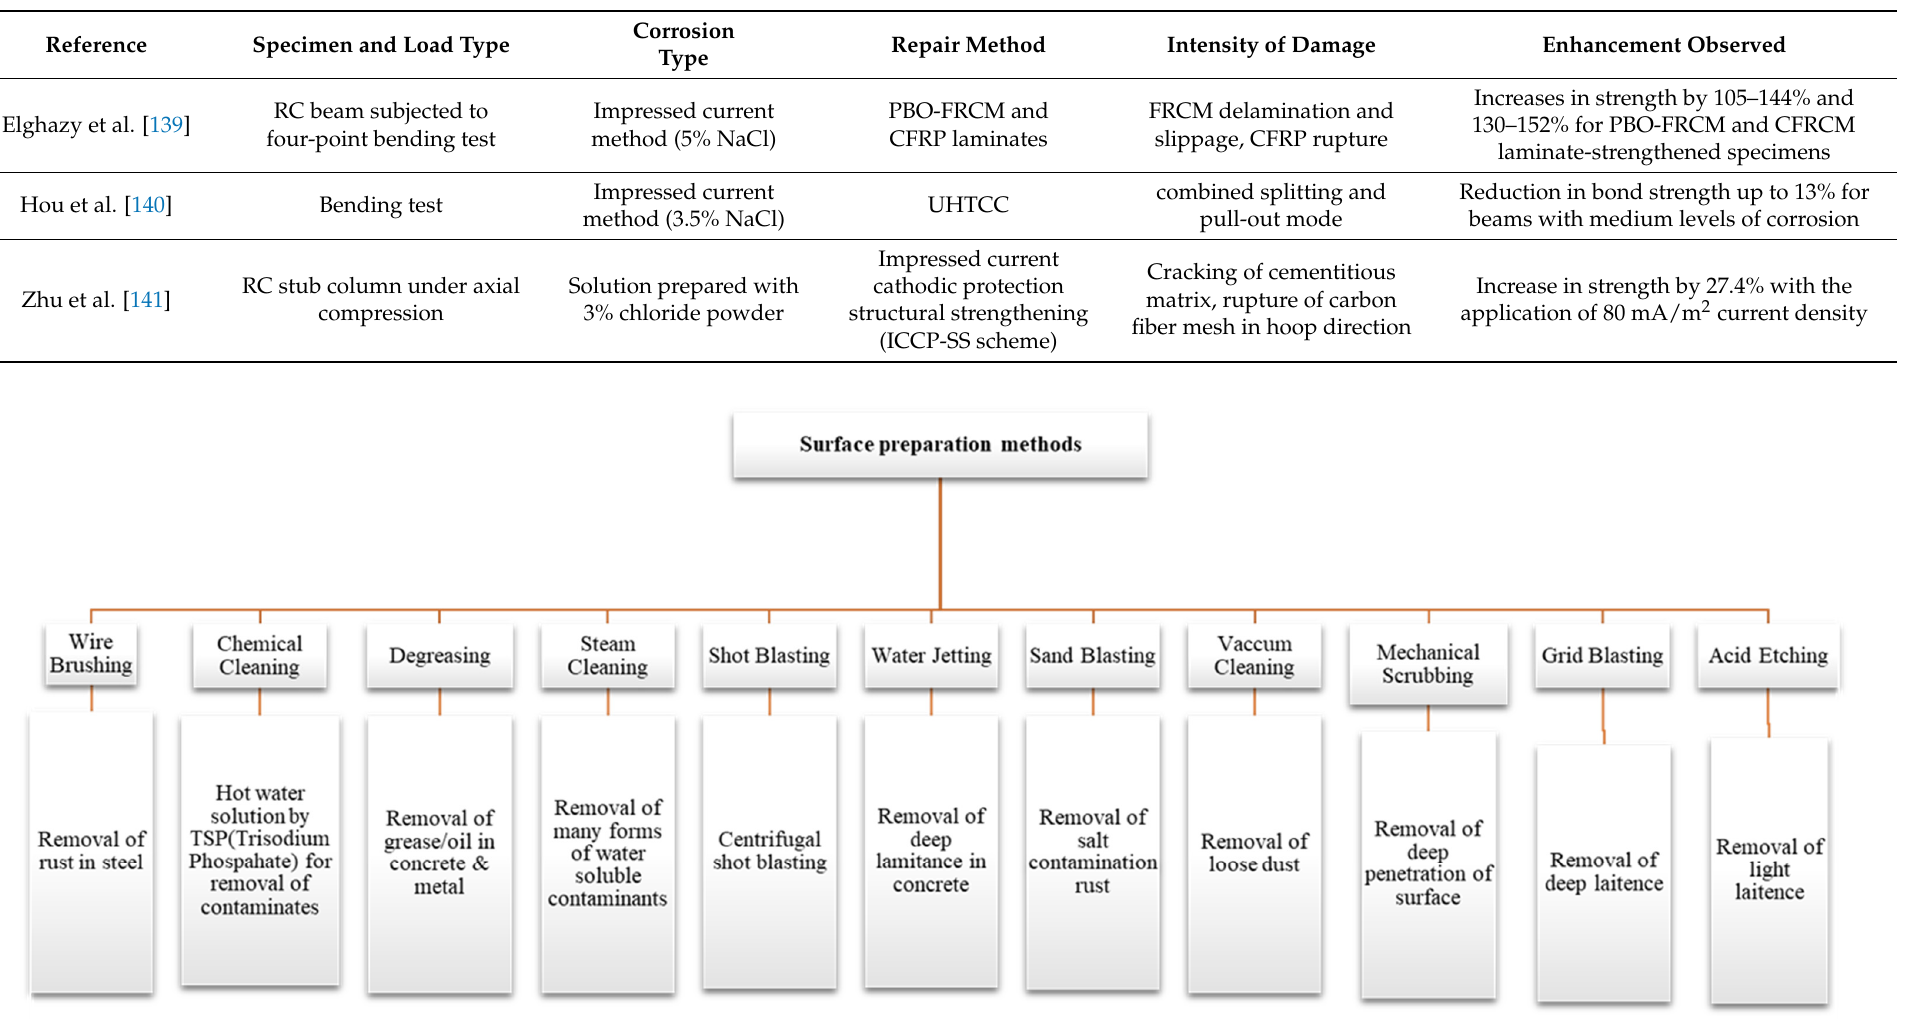
Figure 13. Surface preparation methods required prior to strengthening.